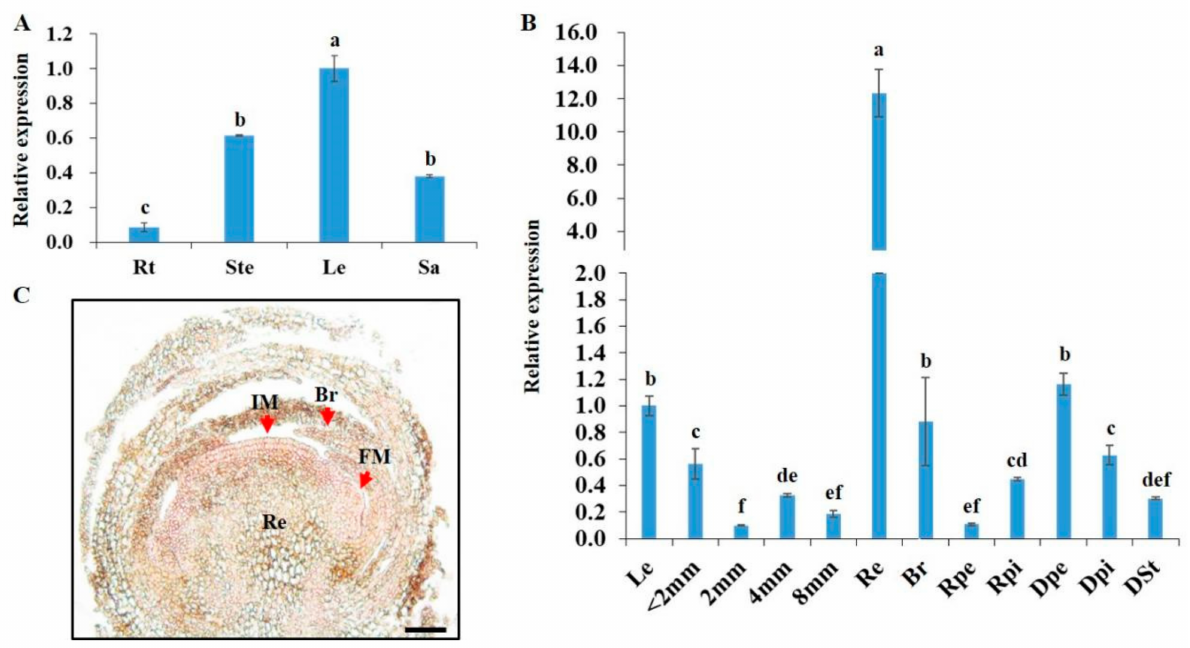
Figure 2. Transcriptional profiling of CmFL3 . The relative expression level of CmFL3 in ( A ) vegetative stage and ( B ) reproductive stage under short-day conditions quantified using qRT-PCR. In situ localization of CmFL3 in ( C ) inflorescence bud (diameter < 2 mm). Rt, root; Ste, stem; Le, leaf; Sa, shoot apex; Rpe, ray floret petal; Rpi, ray floret pistil; Dpe, disc floret petal; Dpi, disc floret pistil; Dst, disc floret stamen; IM, inflorescence meristem; FM, flower meristem; Br, bract; Re, receptacle. The IM, FM, and Br ( C ) are indicated by red arrows. Values ( A , B ) represent mean ± SE ( n = 3). Significant differences were analyzed using Duncan’s multiple range test. Different letters above the bars represent significant differences ( p < 0.05). Bar = 200 µ